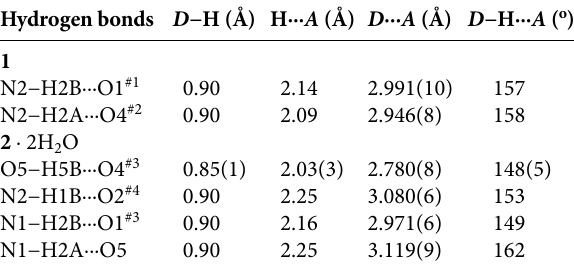
Table 3. Geometrical parameters for hydrogen bonds